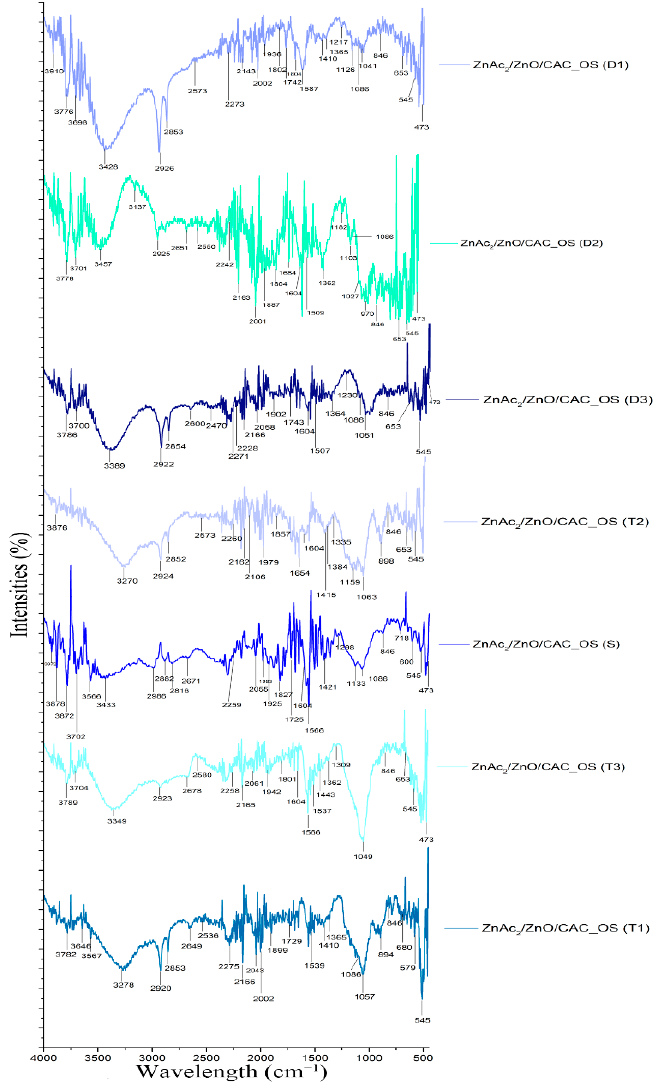
Figure 7. FTIR spectra of ZnAc 2 /ZnO/CAC_OS through three H 2 S adsorption–desorption cycles.